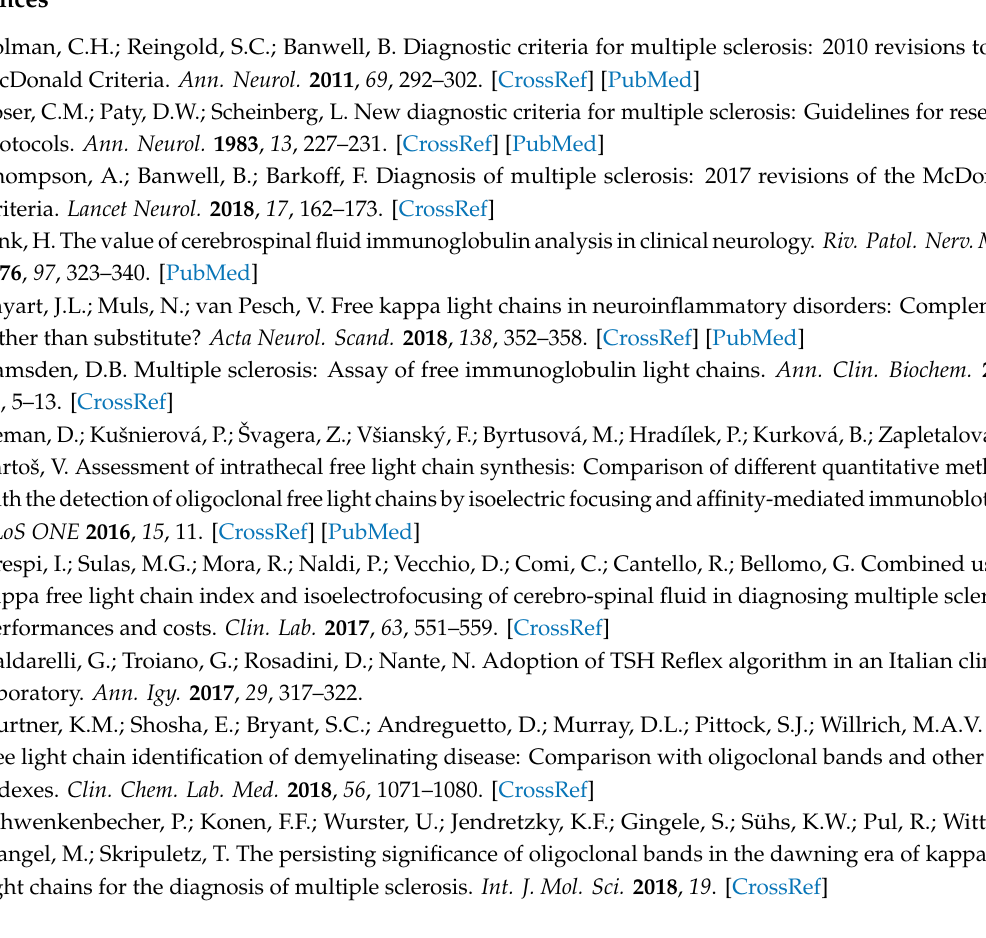
Figure S1: KFLC loc and IgG loc in MS (group 1), ID (group 2) and NID (group 3) patients; Figure S2: Correlations between KFLC index, IgG index, KFLC loc and IgG loc in patients with multiple sclerosis; Table S1: Correlations between IgG index and KFLC index among patients with multiple sclerosis (MS), inflammatory diseases (ID) and non-inflammatory diseases